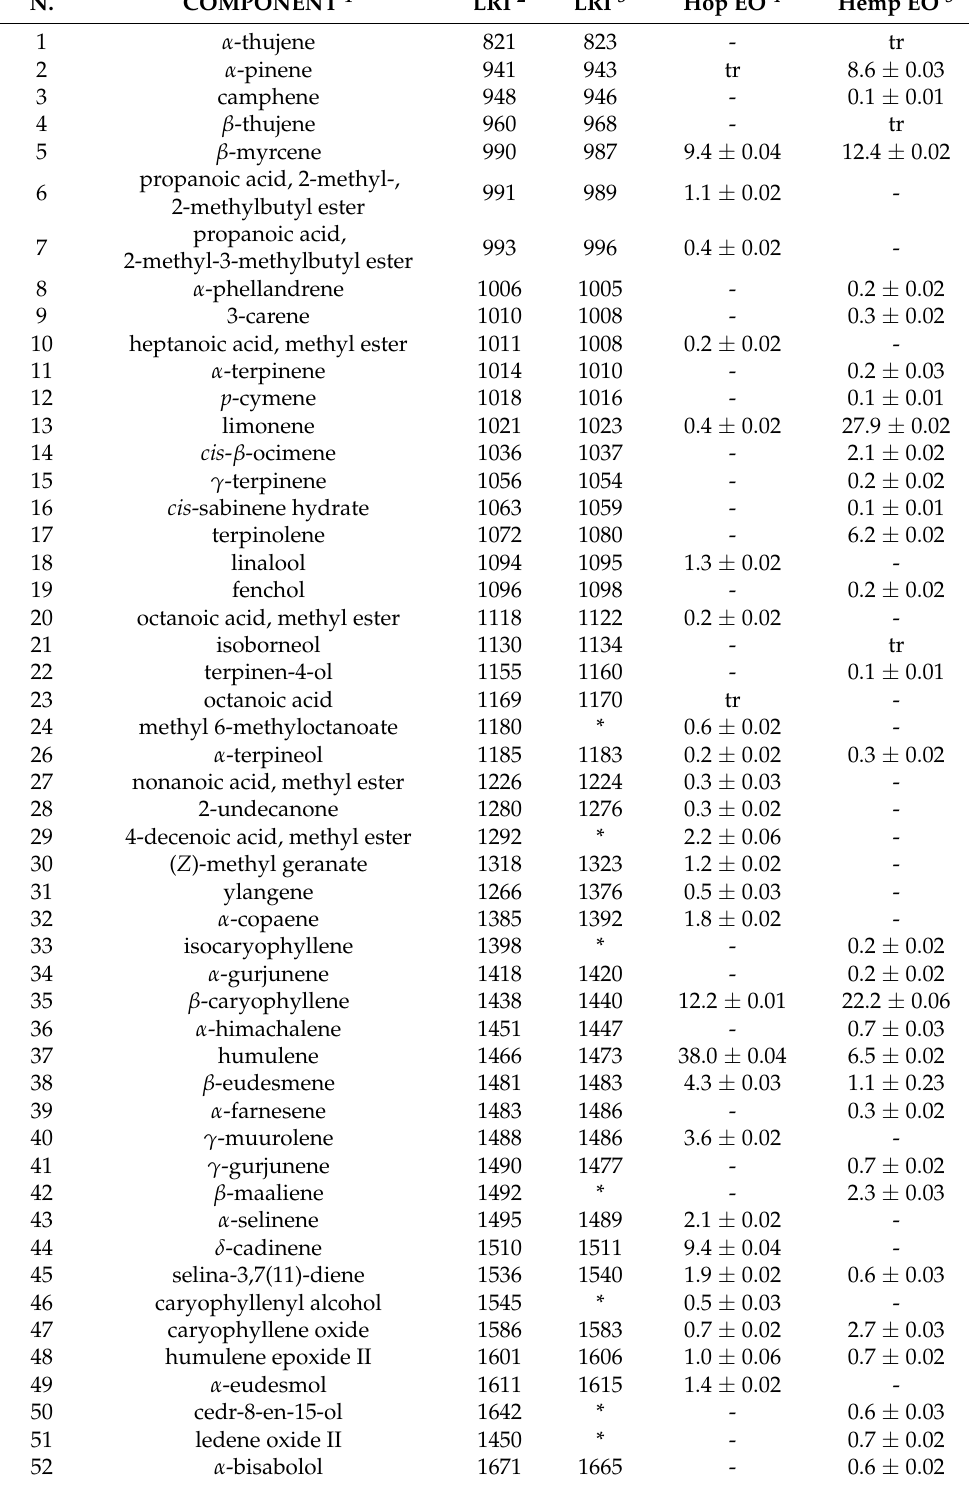
Table 1. Chemical composition (percentages mean values ± standard deviation) of hop and hemp EO.